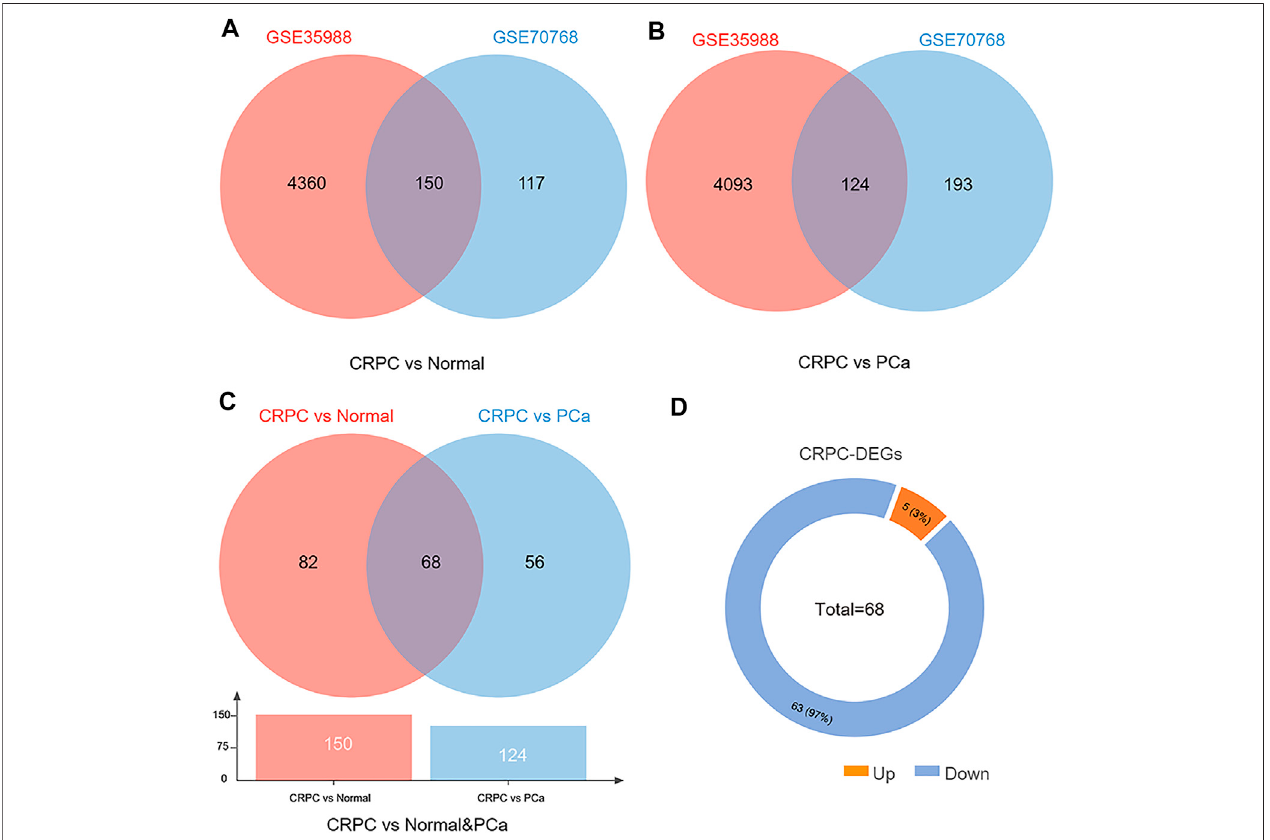
FIGURE 3 | Venn diagram of DEGs compared CRPC with normal and PCa samples. (A) DEGs of CRPC compared with normal samples in both GSE35988 and GSE70768. (B) DEGsofCRPCcomparedwithPCainbothGSE35988andGSE70768. (C) DEGsofCRPCcomparedwithnormalandPCasamplesinbothGSE35988 and GSE70768. (D) The number of upregulated and downregulated DEGs.